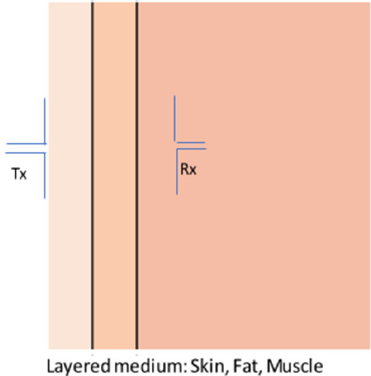
Figure 3. Propagation of the wave from air to layers equivalent to human tissue.